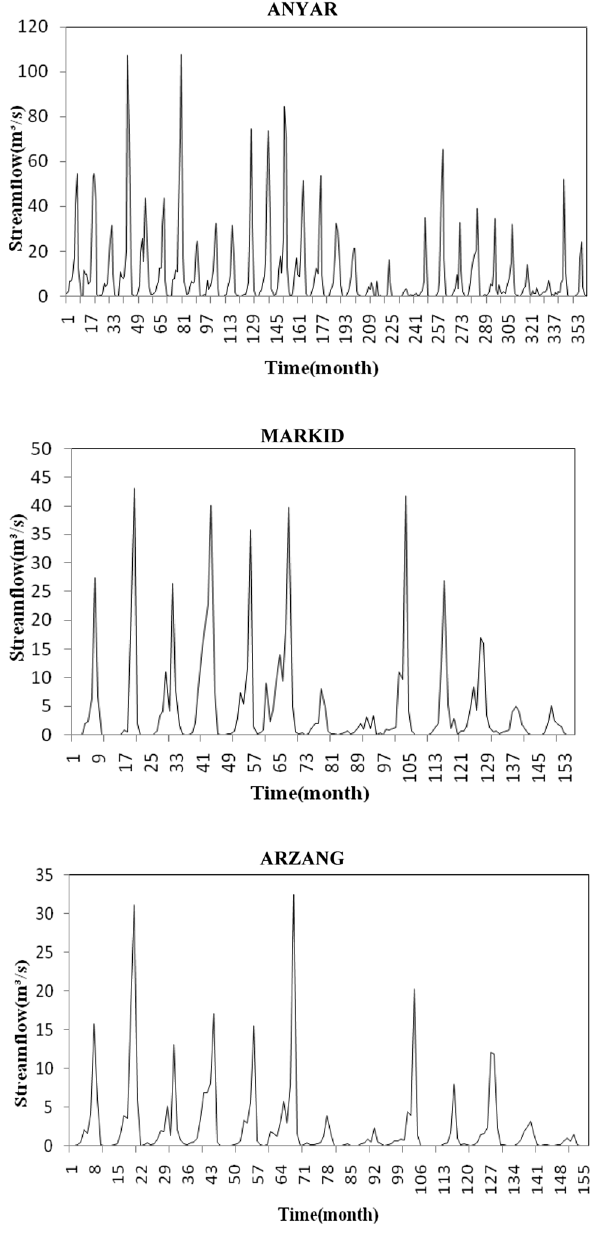
Fig. 2 Monthly river flow time series at the Ajichay river